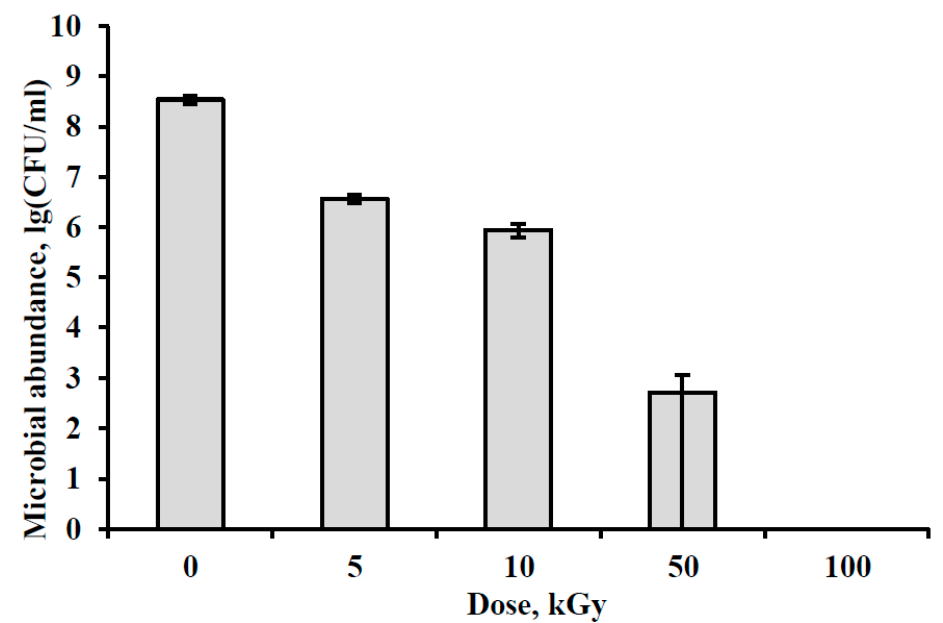
Figure 3. Impact of high energy electrons irradiation on the number of Deinococcus radiodurans VKM B-1422 T viable cells. Error bars are in accordance with the confidence interval for p < 0.05.